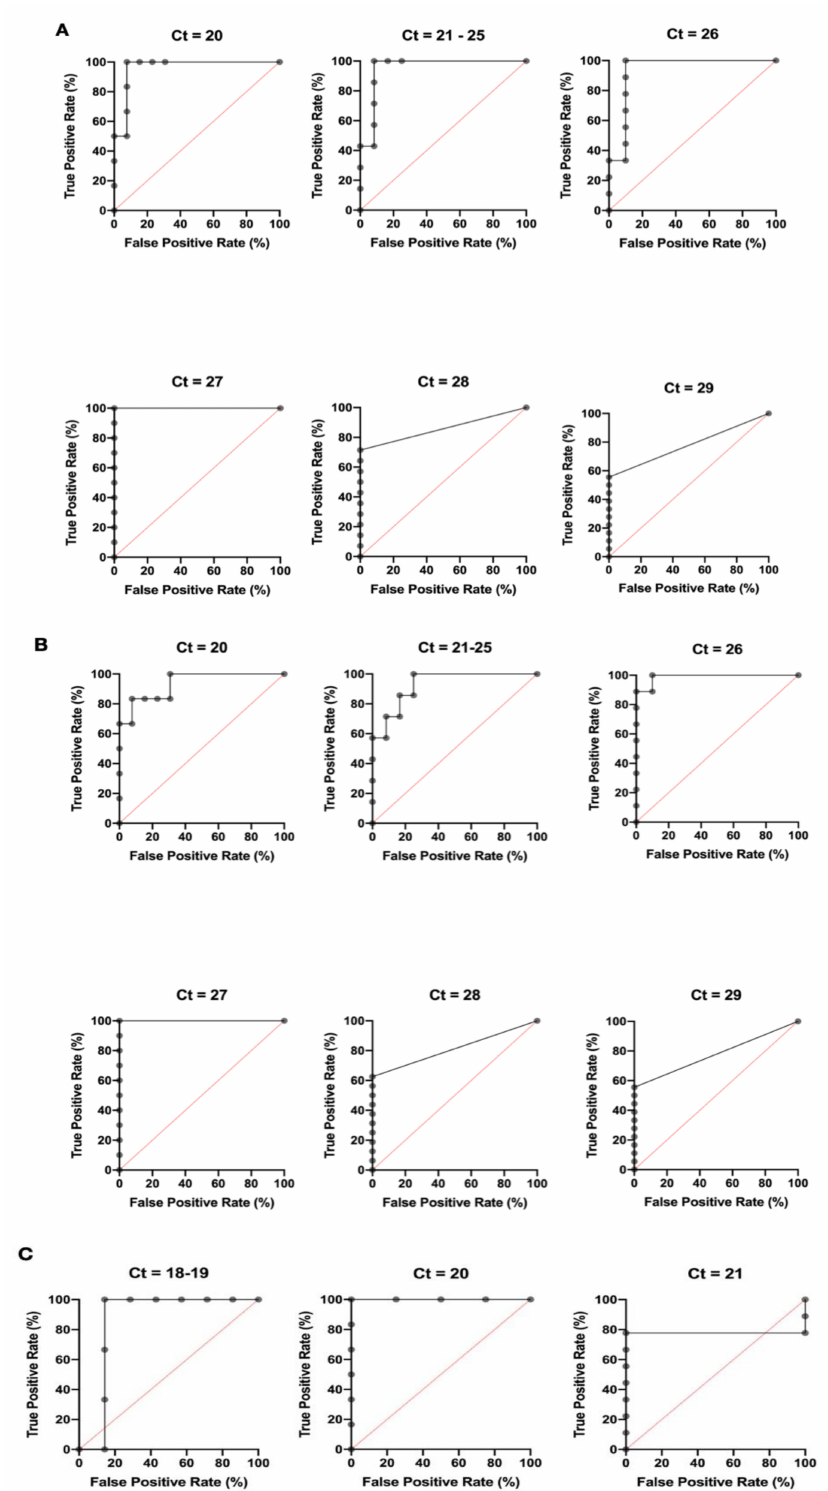
Figure 3. Performance of CHIKV Lateral Flow Test. Receiver operating characteristic (ROC) curve analysis of PCR-tested patient samples. The lateral flow test was constructed with Combination A antibodies using 19 samples from Honduras ( A ), Combination B antibodies using 19 samples from Honduras ( B ), and Combination B antibodies using 10 samples from Colombia ( C ). Incremental Ct values are used to characterize positive and negative samples, to which lateral flow test performance is compared. Test performance is demonstrated in terms of true positive rate (%) versus false positive rate